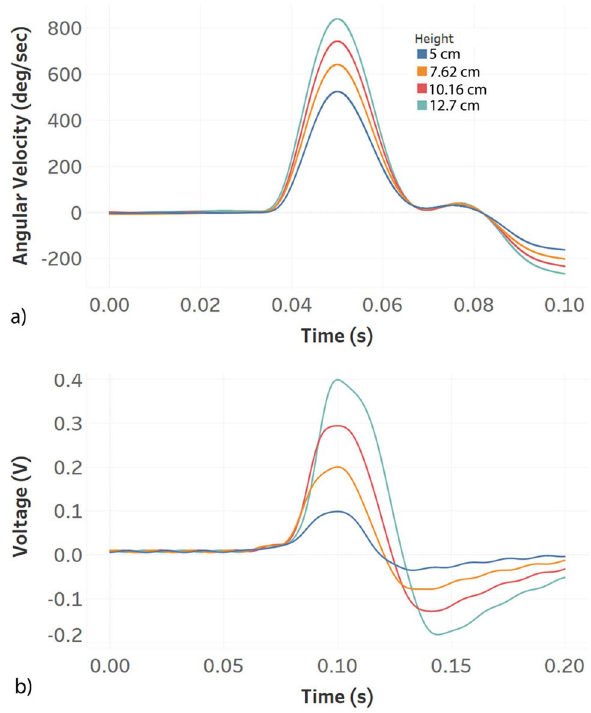
Figure 4. For different drop heights ( a ) filtered angular velocity and ( b ) filtered voltage.